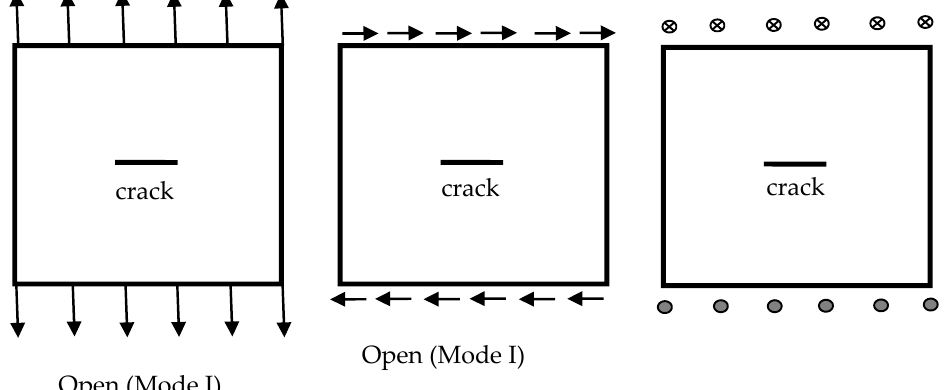
Figure 1. Loading and fixed conditions of a hole in the square composite plate and the sensor positions (no. 1~8).